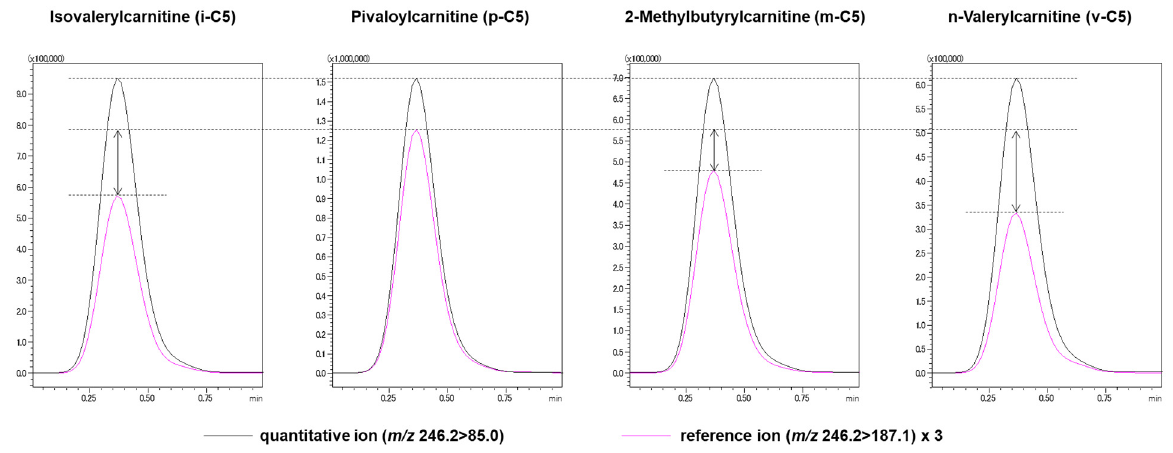
Figure 3. MRM chromatograms of C5-acylcarnitine isomers.